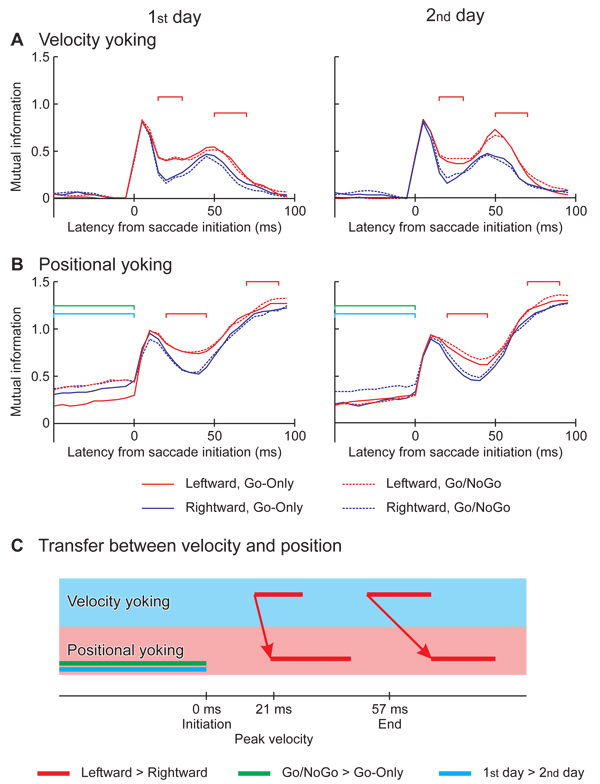
Time courses of MI:A. Between the left and right eyes’ velocities; B. Between the left and right eyes’ positions. The samples were paired between the eyes without delay relative to each other. The overestimation of MI was corrected by the difference between the MIOri and the mean MI obtained from 100 sample randomizations (): . MICor is averaged among all subjects for the saccade toward the left (red lines) and right (blue lines) in the sessions of Go-Only (solid lines) and Go/NoGo (dashed lines), on the 1st day (left panels) and 2nd day (right panels). Horizontal axes are the latency from the saccade initiation. The latencies of significantly stronger relationship are denoted by red square brackets for the leftward saccade relative to the rightward, by green square brackets for the saccades in the Go/NoGo sessions than the Go-Only except for the leftward saccade on the 2nd day, and by cyan square brackets for the saccades on the 1st day than the 2nd day except for the leftward saccade in the Go-Only session. The significant differences were revealed by ANOVA factoring the saccade direction, the session type, the experiment day and the subject (p < 0.05 for 10 ms or more). C. Time courses comparisons between the velocity MICor and the positional MICor. The red arrows that link the red horizontal bars suggest causal relationship between the velocity MICor and positional MICor with respect to the significant difference between the leftward and rightward saccades. The green horizontal bar indicates the latency of significant cognitive load effect, and the cyan one indicates that of significant day effect, obtained only for the positional MICor.